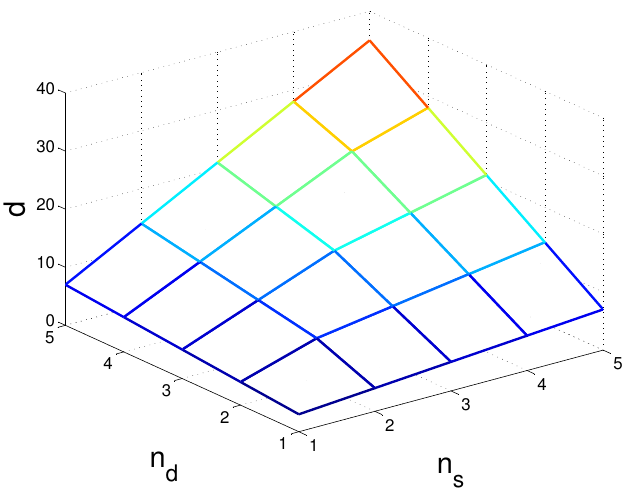
Figure 4. Diversity performance of DF-AF selection MIMO